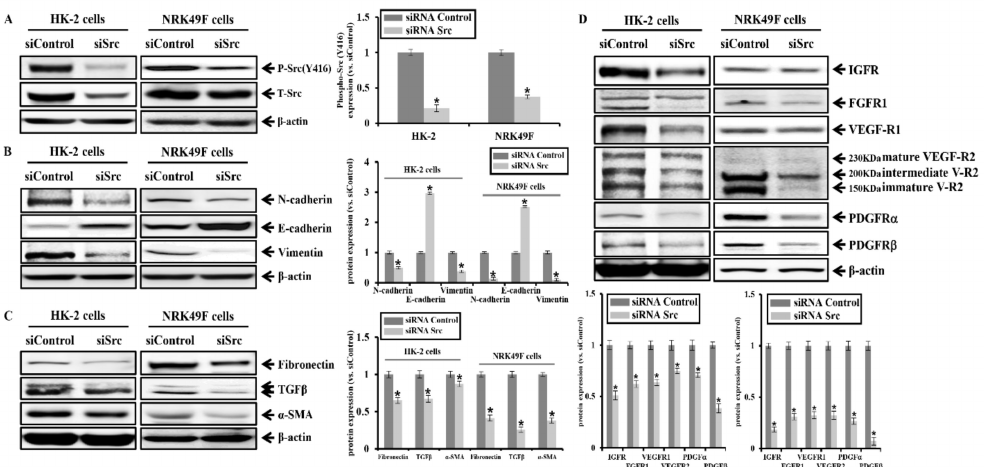
Figure 7. E ff ects of Src siRNA on EMT, pro-fibrotic marker, and RTKs in HK-2 and NRK49F cells. ( A ) Protein expression of the phosphorylated Src (Y416) and total Src by Src siRNA transfection was analyzed. ( B ) Protein expression of N-cadherin, E-cadherin, vimentin by Src siRNA transfection was analyzed. ( C ) Protein expression of fibronectin, TGF β , and α -SMA by Src siRNA transfection was analyzed. ( D ) Protein expression of IGFR, FGFR1, VEGFR1, VEGFR2, PDGFR α , and PDGFR β by Src siRNA transfection was analyzed. Each column represents the mean ± SEM. * p < 0.05, compared with the siRNA control.